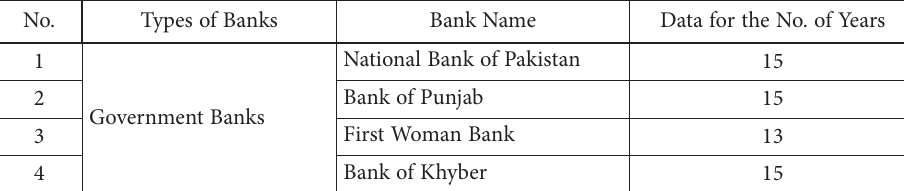
Table 1. Sample summary (source: